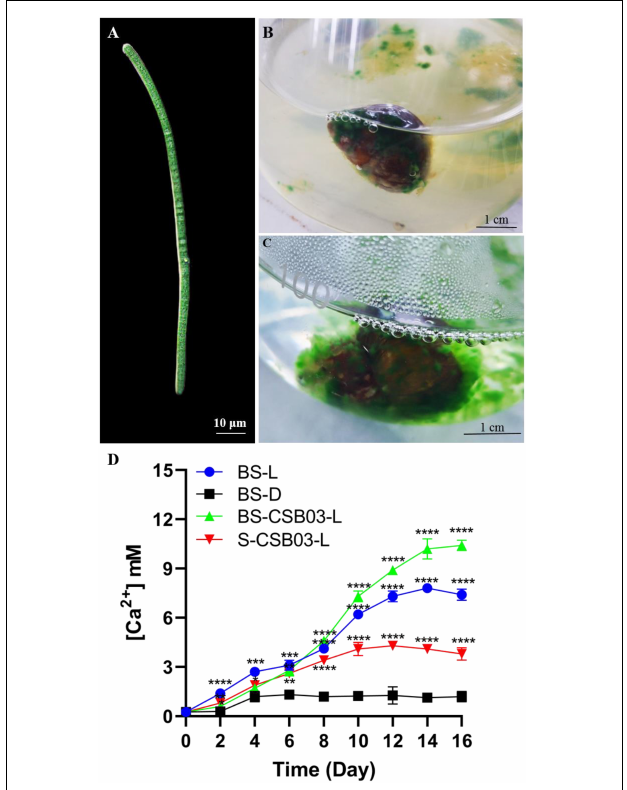
FIGURE 9 | Cyanobacterial CSB03 morphology and changes in Ca 2 + concentration during the bioerosion of snail shells. (A) Morphology of cyanobacterial CSB03; (B) the early stage of Cyanobacteria eroding the snail shell; (C) the later stage of Cyanobacteria eroding the snail shell; (D) the change of Ca 2 + concentration in the medium during the bioerosion process of the snail shell. BS-D, control group, which no light, 30 ◦ C conditions; BS-L,